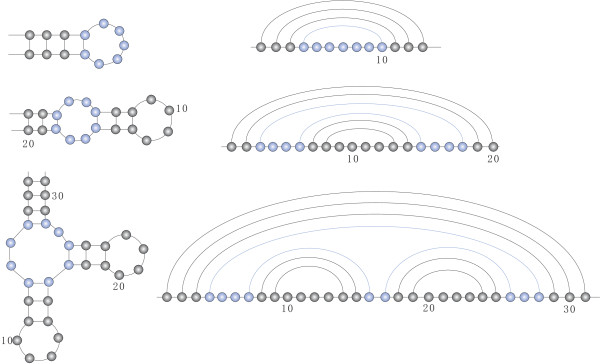
The standard loop-types. The standard loop-types: hairpin-loop (top), interior-loop (middle) and multi-loop (bottom). These represent all loop-types that occur in RNA secondary structures.